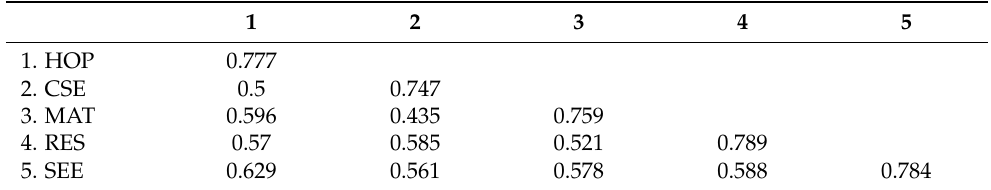
Table 3. Fornell–Larcker criterion.